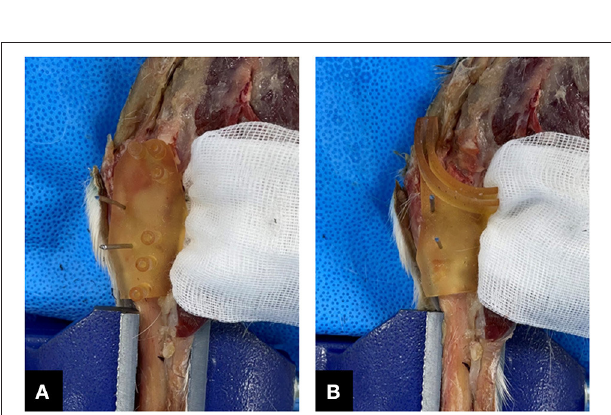
FIGURE 2 | Customized three-dimensional printing surgical guides. TPLO drill guide (A,C) and TPLO saw guide (B,D) . Arrows represent the two holes for temporary fixation. TPLO, tibial plateau leveling osteotomy.